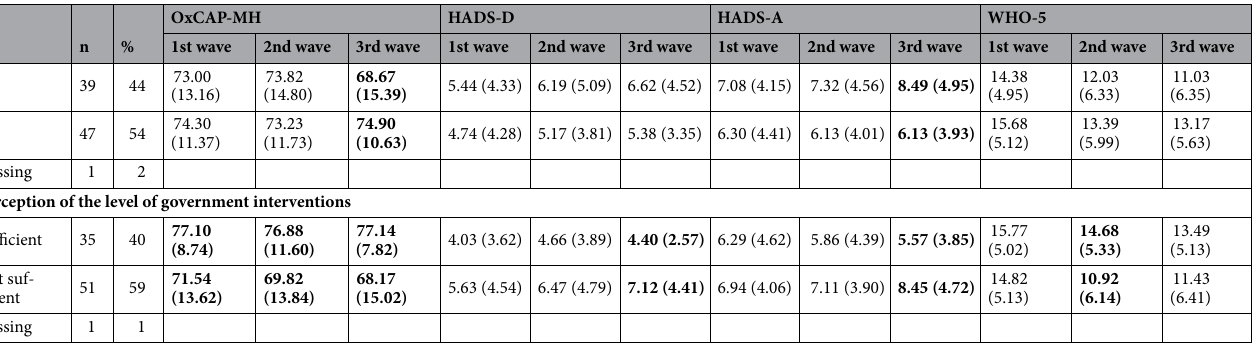
Table 1. Baseline, follow-up and change scores of capability wellbeing, mental health, and general wellbeing outcomes across the three lockdowns by demographic and socioeconomic characteristics. Means and SD in parentheses (); statistically significant coefficients (p < 0.05) in bold; p < 0.05, based on t-test or ANOVA; *based on MSPSS score (scores ranging from 1 to 5 were categorised as moderate to low level of support; whilst scores from 5.1 to 7 could be considered high level of support). OxCAP-MH Oxford CAPabilities questionnaire- Mental Health, HADS-D Hospital Anxiety and Depression Scale Depression subscale, HADS-A Hospital Anxiety and Depression Scale Anxiety subscale, WHO-5 World Health Organisation-Five Well-being Index.